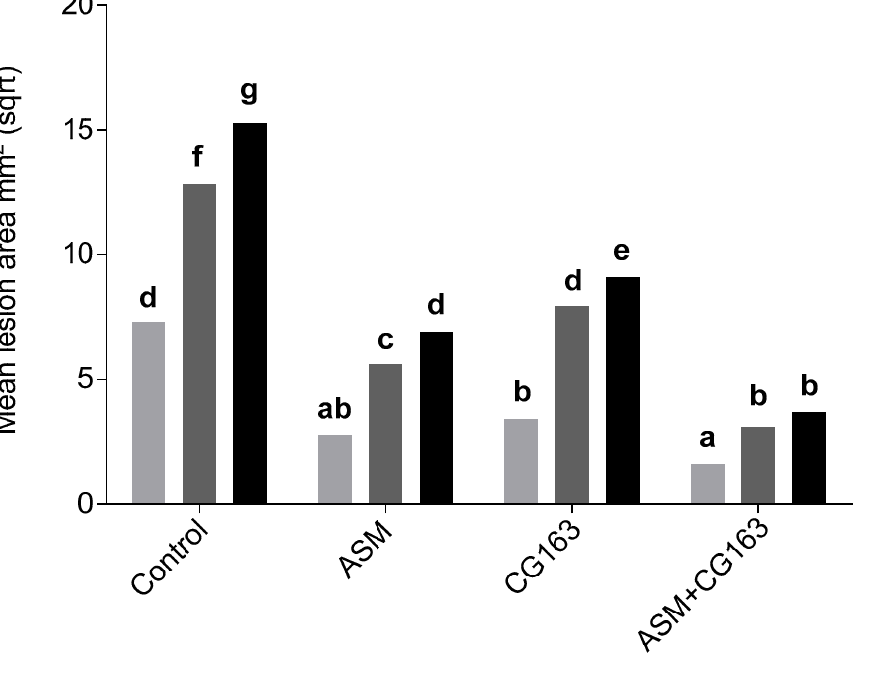
Figure 1. Mean lesion area in Actinidia chinensis var. deliciosa ‘Hayward’ potted plants treated with acibenzolar-S-methyl (ASM), Aureobasidium pullulans isolate CG163 (CG163), combination of ASM and CG163 (ASM + CG163) or untreated (control), at seven and one days before inoculation with 2 × 10 7 CFU/mL Pseudomonas syringae pv. actinidiae (Psa). Disease symptoms were assessed 8, 14 and 19 days post inoculation. Values are means of 15 biological replicates with six inoculation spots on three leaves per rep. Plant replicate was included as a block effect for statistical analysis. Bars with different letters, based on square-root-transformed means are significantly different according to Fisher’s Least Significant Difference test (LSD) at the 5% level.